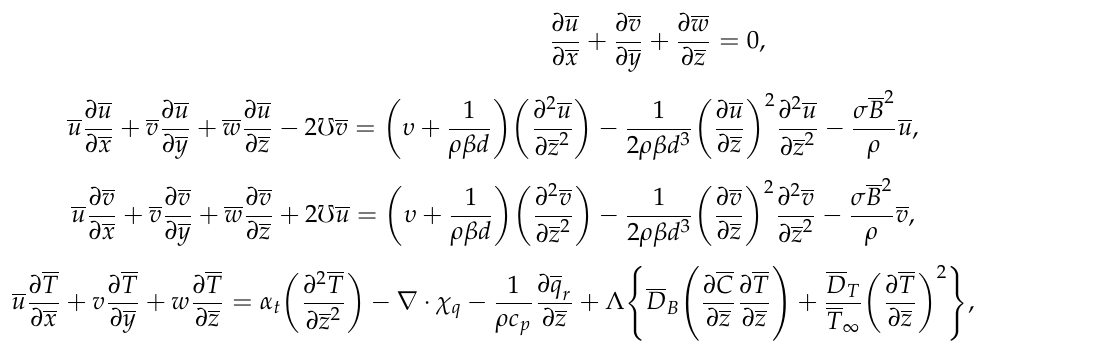
Figure 1. Three-dimensional bi-directional stretching sheet of Powell–Eyring fluid flow.